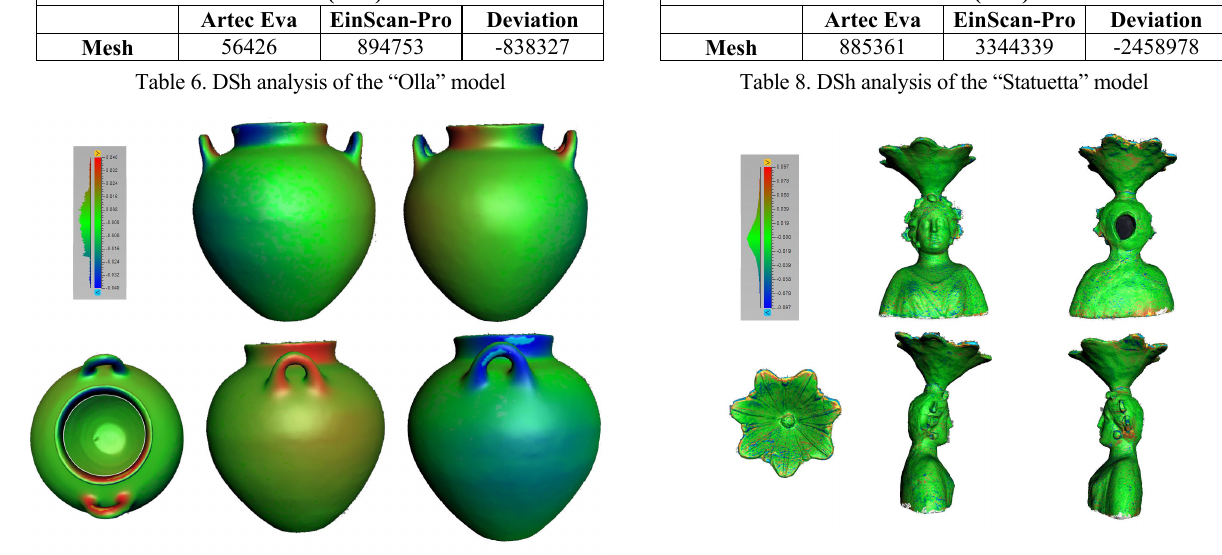
Figure 10. DF analysis of “Statuetta”